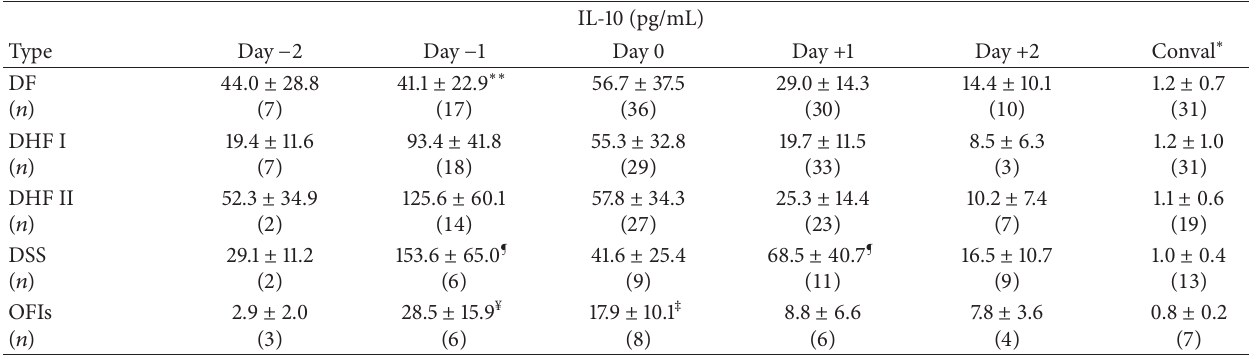
Table 5: Mean ± SD of the level of interleukin-10 (IL-10) in patients with DF, DHF grades I and II, DSS, and OFIs patients, followed by the day of illness related to fever.